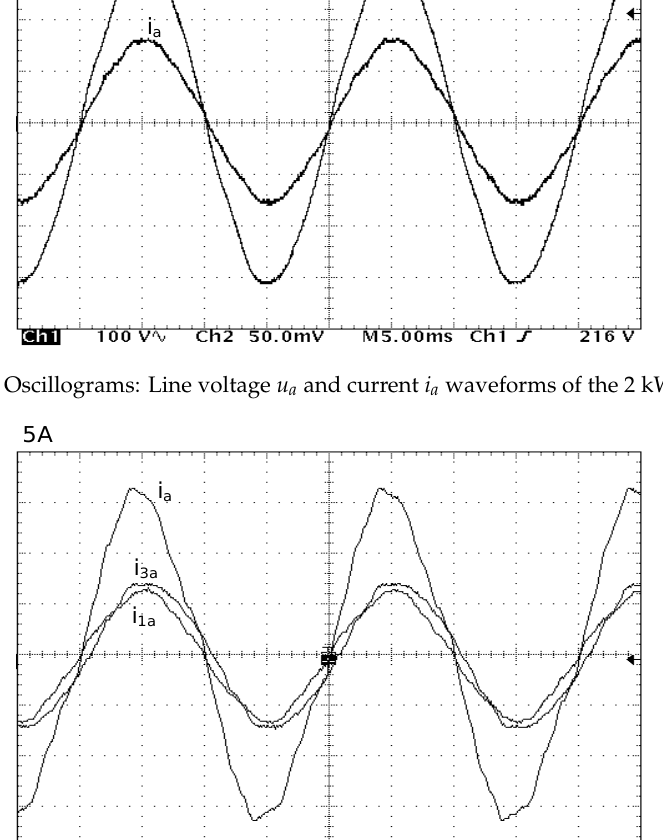
Figure 23. Oscillograms of line current i a and winding currents 3CR λ 2: i 1 a , i 3 a